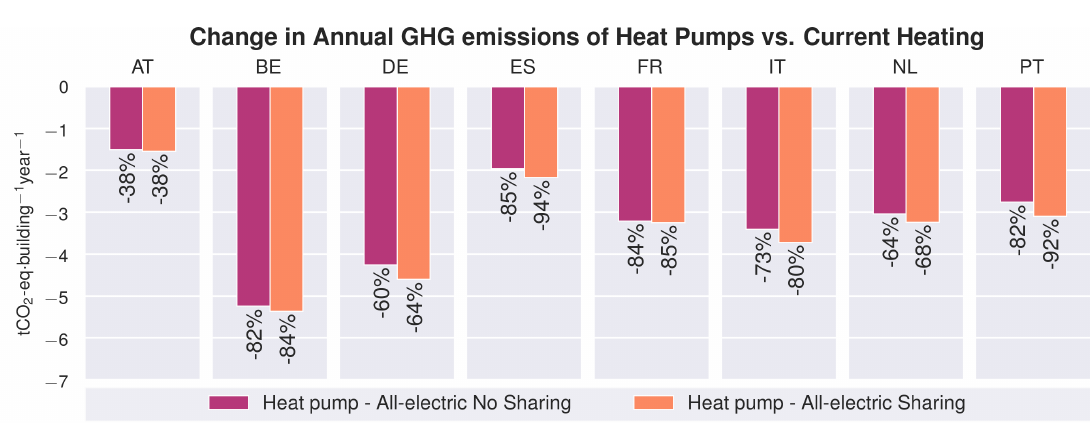
Figure 7. Greenhouse gas emission reduction potentials for heat supply with heat-pumps (HPs) in the eight selected countries. Data are shown as the change in annual emissions related to heat supply, expressed as the average per building in the community, including both energy use (fuel or electricity) and upstream emissions related to manufacturing of the heat supply